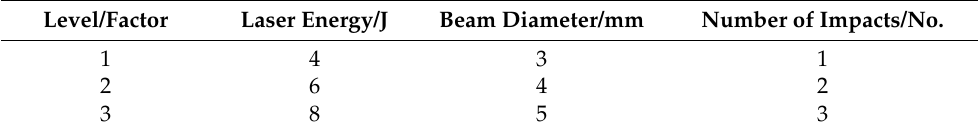
Table 2. Test factors and levels.